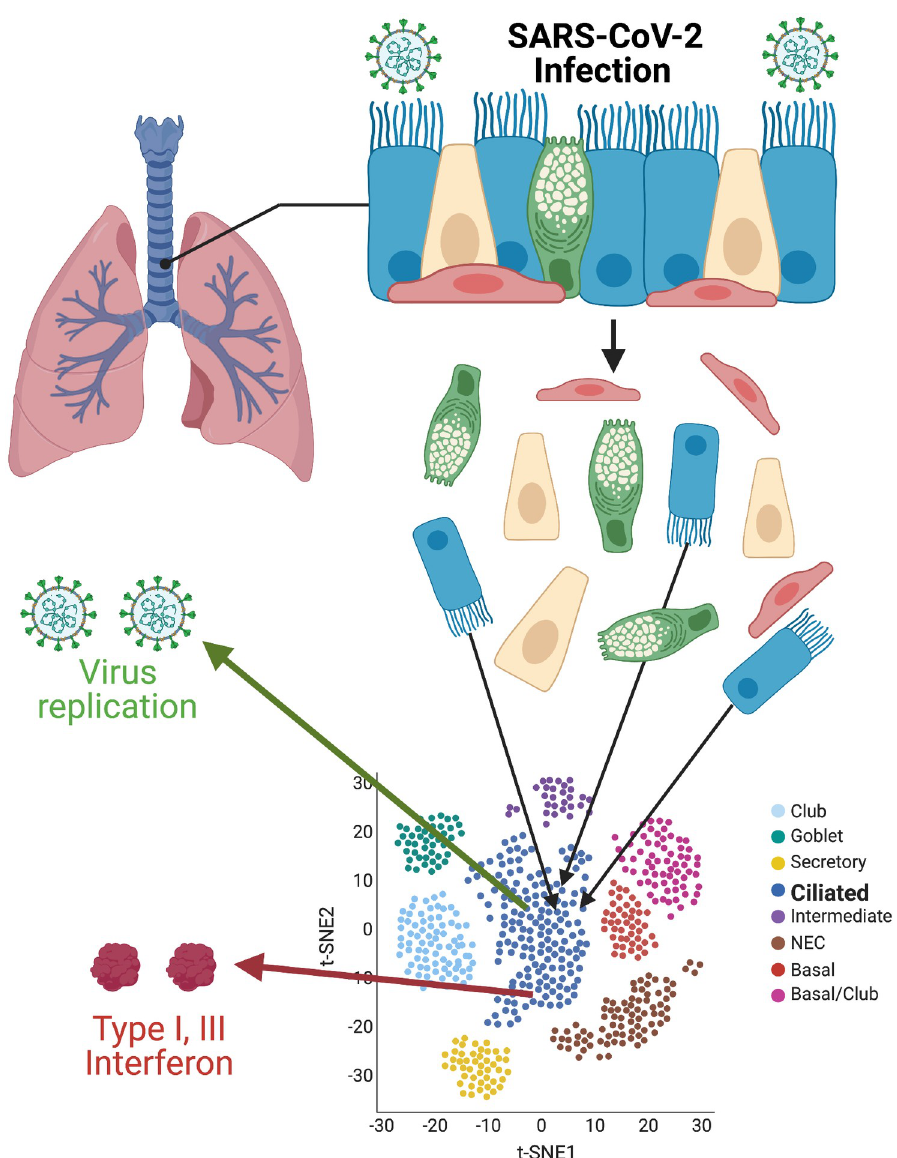
Fig 1. Single-cell resolution of SARS-CoV-2 infection. Primary cultures of well-differentiated bronchial epithelial cells, grown on permeable supports at ALIs, are infected with SARS-CoV-2, then separated for subsequent single-cell RNA sequencing. Using t-SNE statistical methods, cells with similar transcriptome profiles are group-clustered on two-dimensional plots. Individual cells containing SARS-CoV-2 RNAs and antiviral interferon transcripts are identified within clusters. Images were created with BioRender.com. ALI, air–liquid interface; SARS-CoV-2, Severe Acute Respiratory Syndrome Coronavirus 2; t-SNE, t-distributed stochastic neighbor embedding.